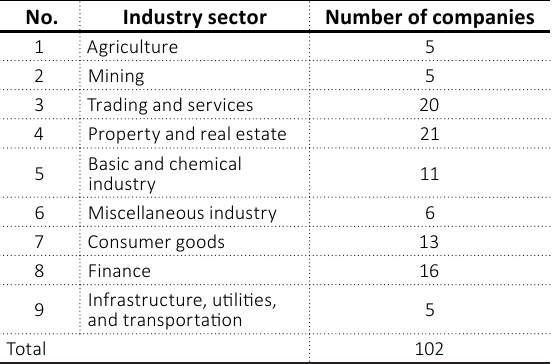
Table 1. Samples distribution based on industry sectors